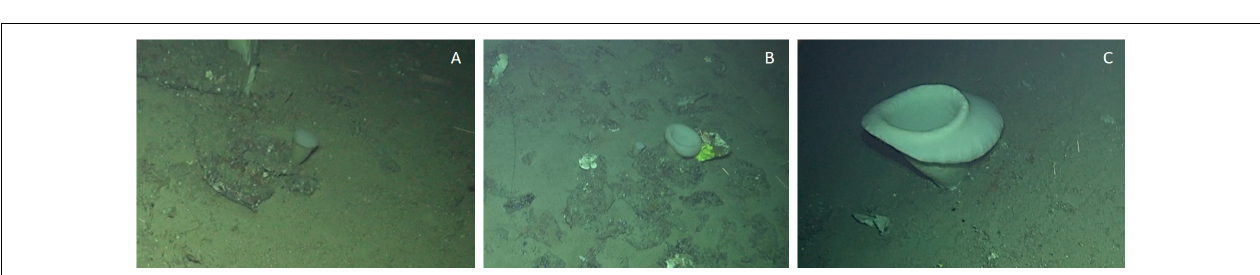
FIGURE 9 | Relationship between annual growth ratios and A. setubalense specimen sizes defined by the four parameters chosen (diameter, height, external cup-perimeter, and cup-surface area).